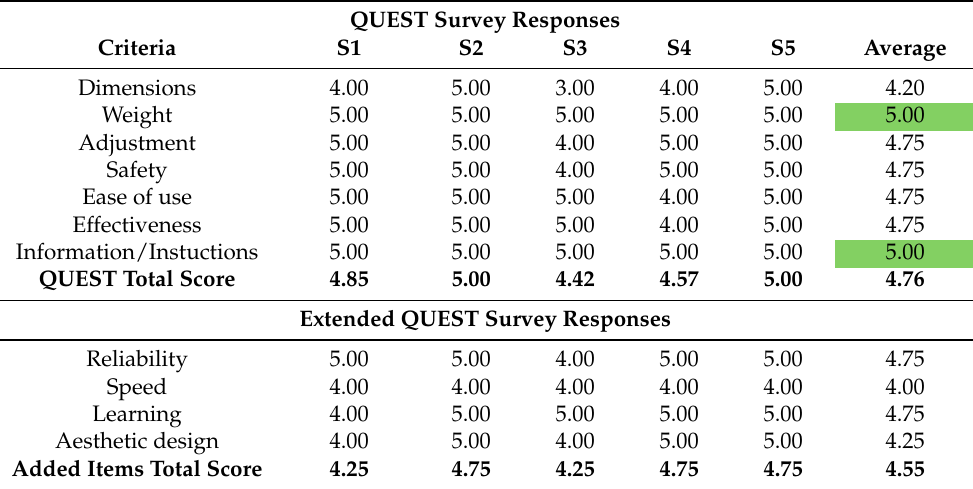
Table 5. Collecting QUEST survey results with extending additional criteria. The highlighted values with green refer to the better